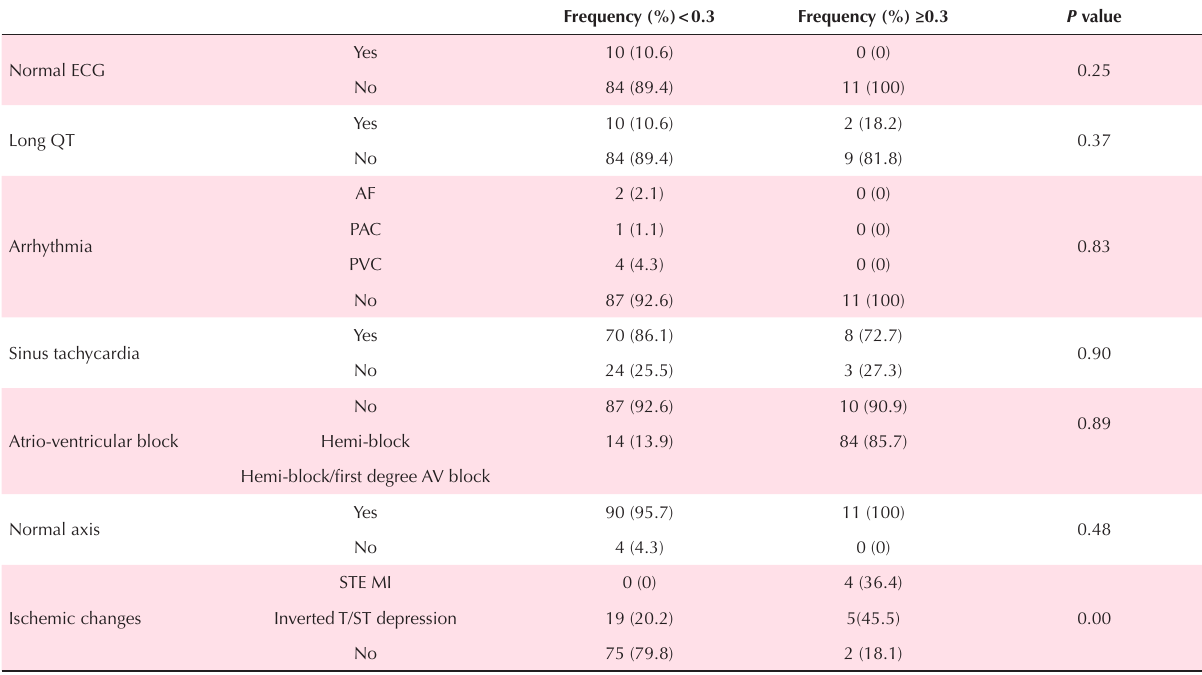
Table 3. Comparison of ECG parameters in patients with elevated and normal troponin level